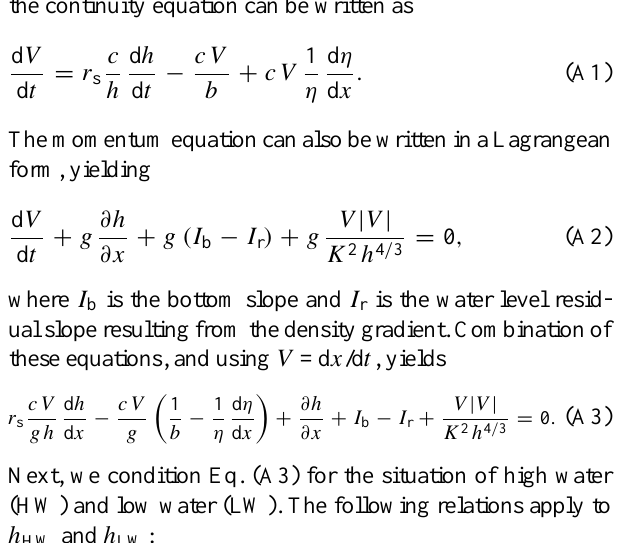
varying depth and only focus on the quadratic velocity.